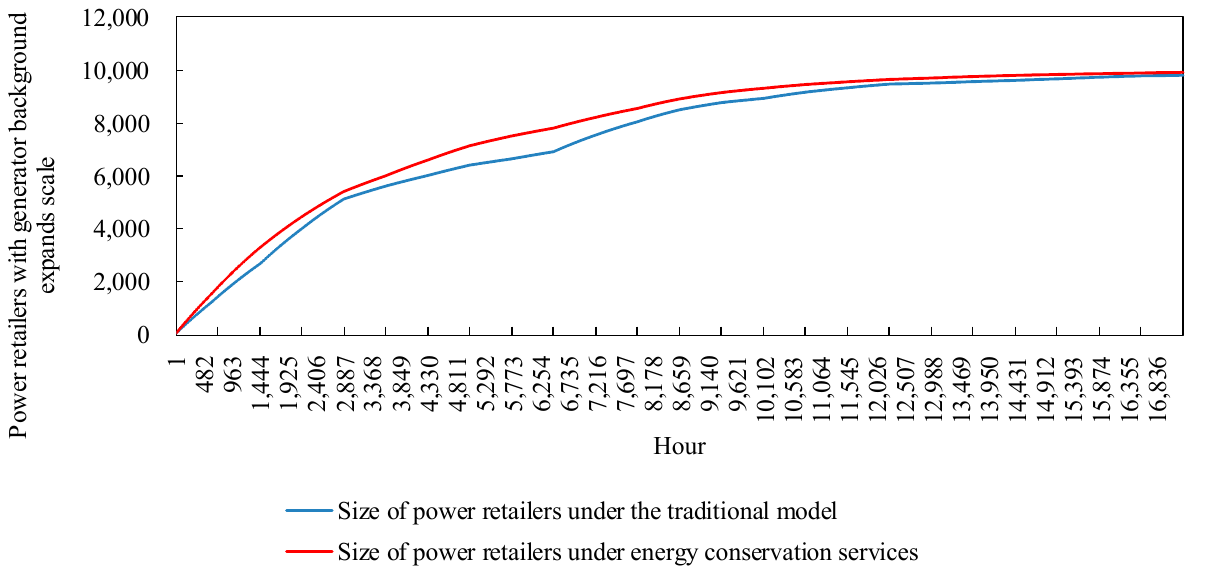
Figure 18. Comparison of the expansion of power retailers considering coal price fluctuations and energy conservation services.